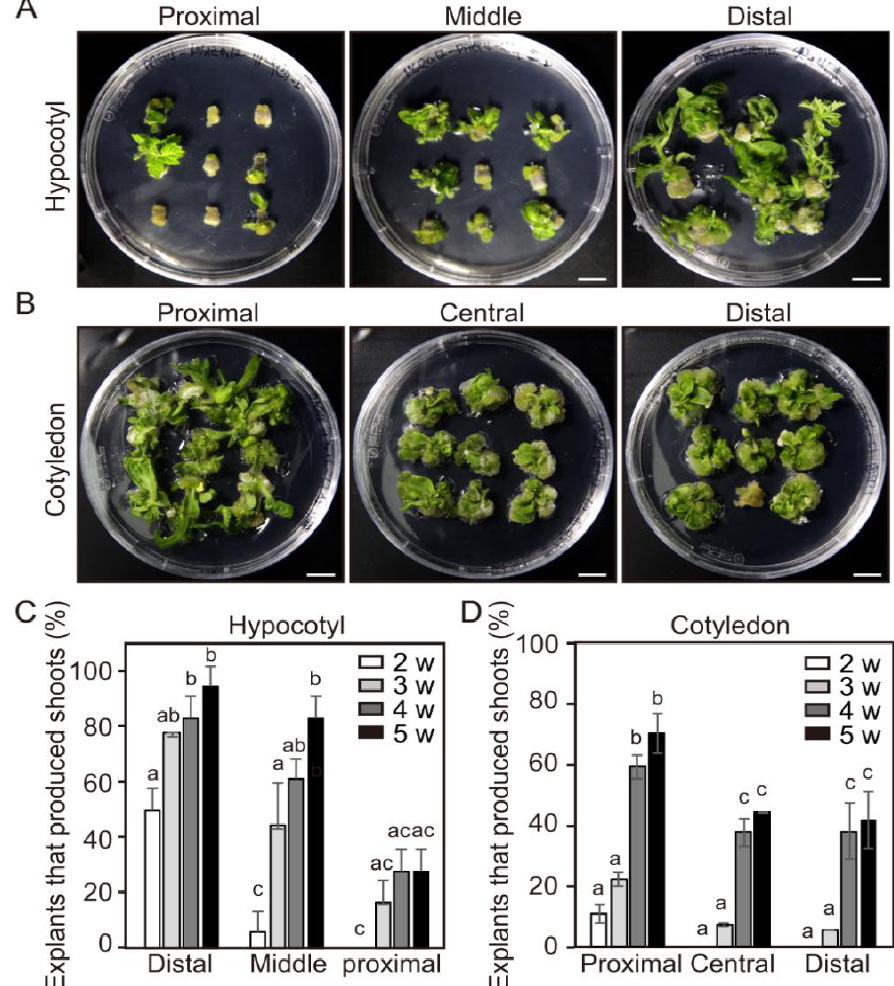
Figure 3. The efficiency of adventitious shoot formation from different segments within individual hypocotyl and cotyledon explants. ( A , B ) Adventitious shoot formation at different positions in DAG4 seedlings of hypocotyl ( A ) and cotyledon ( B ) explants incubated for 4 weeks. Scale bars = 1 cm. ( C , D ) The efficiency of adventitious shoot formation at different positions of DAG4 hypocotyls ( C ) and cotyledons ( D ) tested in shoot induction medium for 5 weeks. Data are representative of three independent experiments and values are expressed in mean ± SD (N = 81). Different letters on the bars indicate significant differences between each treatment (ANOVA followed by a Turkey’s test, p < 0.05). DAG = day after germination; w = weeks.